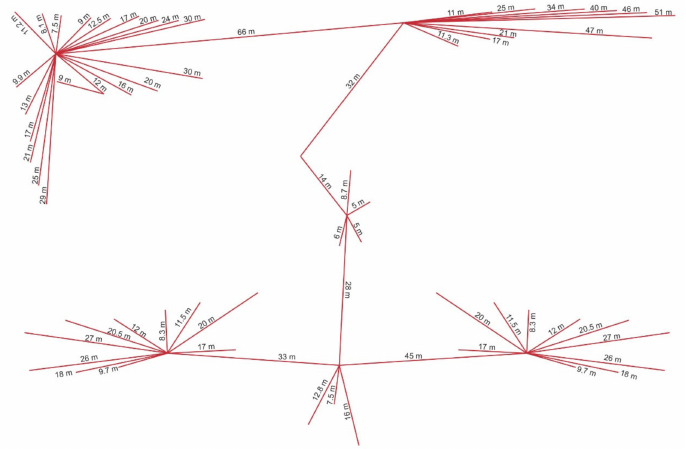
Figure 4 Architectural distances, c (cid:13) Davide